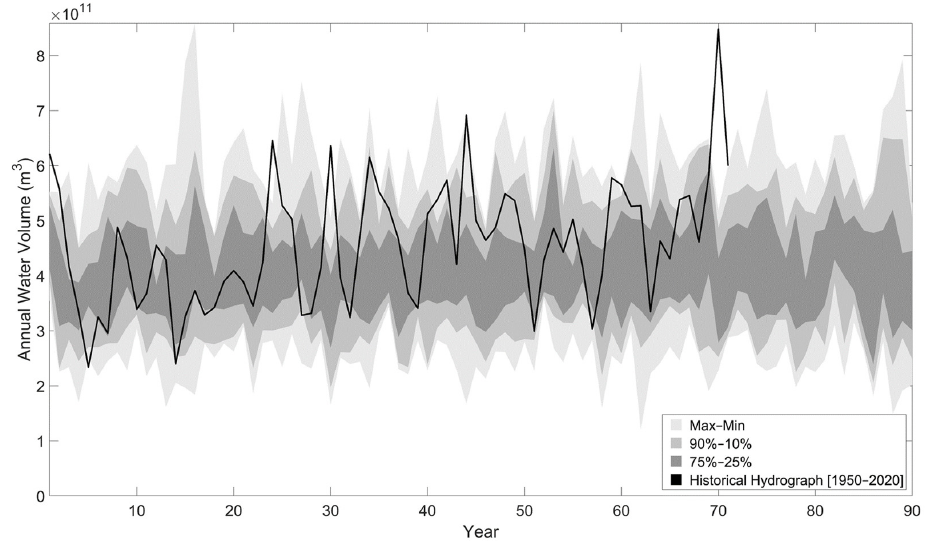
Figure 2. Statistical summary of 16 projected hydrographs for the Lower Mississippi River at the Tarbert Landing, Louisiana station. The historically recorded hydrograph at the same station from 1950–2020 is shown for comparison.